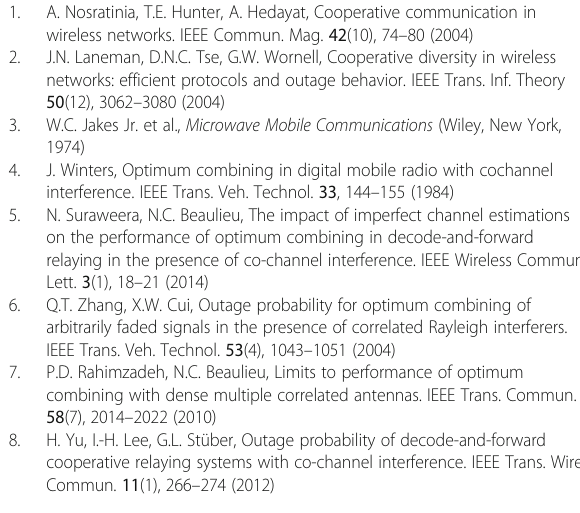
Fig. 6 SER for various r SR and r I ¼ 0 : 3 dB, and P ð R Þ e